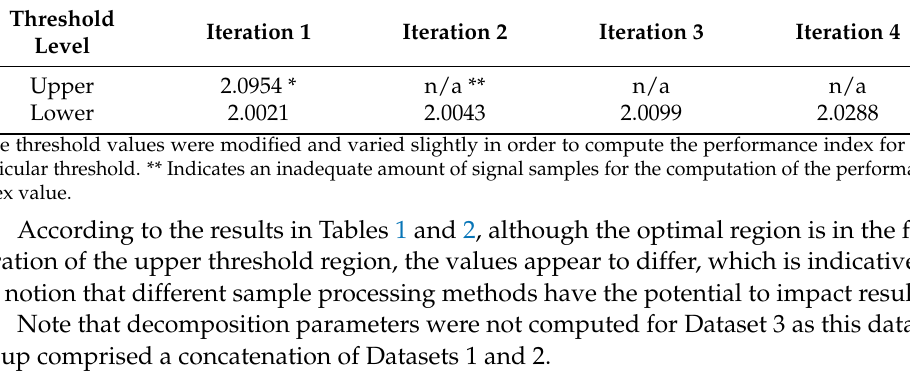
Table 2. LSDL decomposition results for Dataset